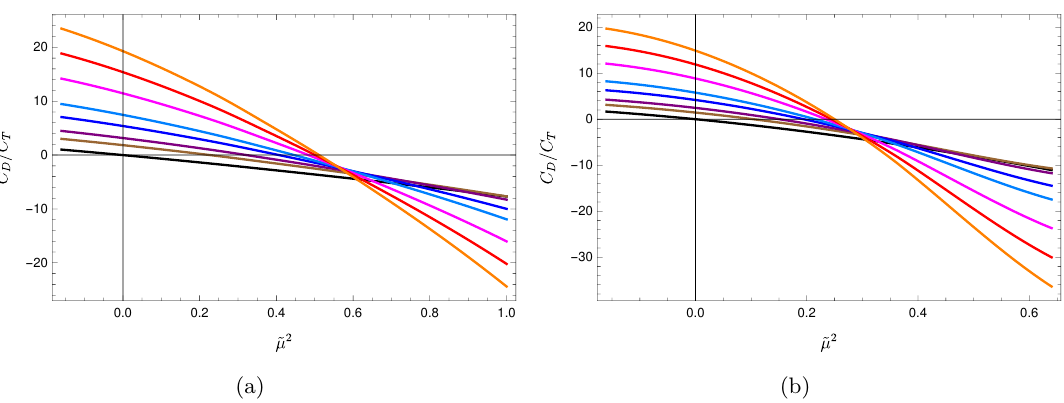
Figure 4 . Numerical results for C D /C T , defined in eqs. (3.13) and (3.35), as a function of ˜ µ 2 , introduced in eq. (3.37), in d = 3 (left) and d = 4 (right). We set ‘ correspond to different values of n . The black curve corresponds to n = 1 , while the upper orange curve corresponds to n = 10 . In between, the curves go in increasing order of n taking values of n = 1 . 5 , 2 , 3 , 4 , 6 , 8 . Note that ˜ µ 2 can be negative, as the chemical potential can take imaginary